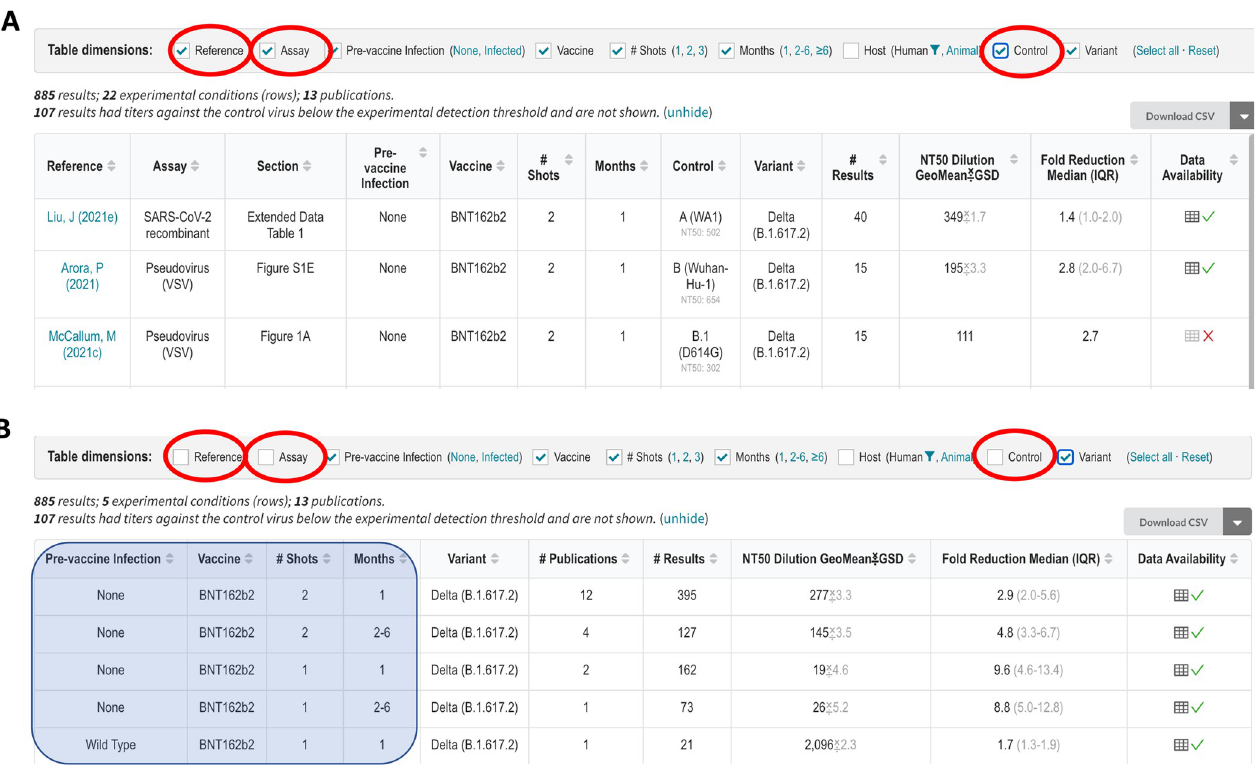
Fig 5. Aggregating the query results for the example shown in Fig 4. The top part of the figure shows the first three of 22 experimental conditions defined by the column headers in which BNT162b2-associated VP was tested for activity against the Delta variant (A). The results for each experimental condition are shown in different rows each containing the geometric mean of the neutralizing antibody titer and the median fold-reduction in titer compared with a control virus. The bottom part of the figure shows that the 22 rows can be displayed using 5 rows by aggregating those results obtained from different references using different assays or different control viruses by deselecting the “Reference”, “Assay”, and “Control” variant (checkboxes within red ovals). The neutralization data are now aggregated according to the number of BNT162b2 immunizations, time since immunization, and whether the VP was obtained from a person who had been infected prior to vaccination (shaded area superimposed on the first four columns). The number of experimental results in each row in Fig 5B is increased because each row may now contain data from more than one